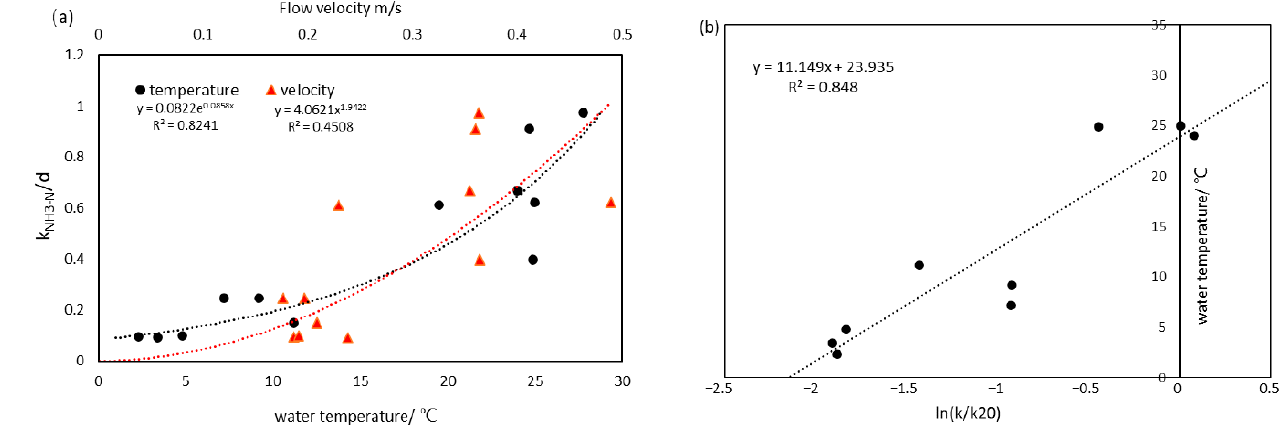
Figure 6. ( a ) The relationship between NH 3 -N degradation coefficient, water temperature, and flow velocity; and ( b ) the calibration of temperature coefficient θ .